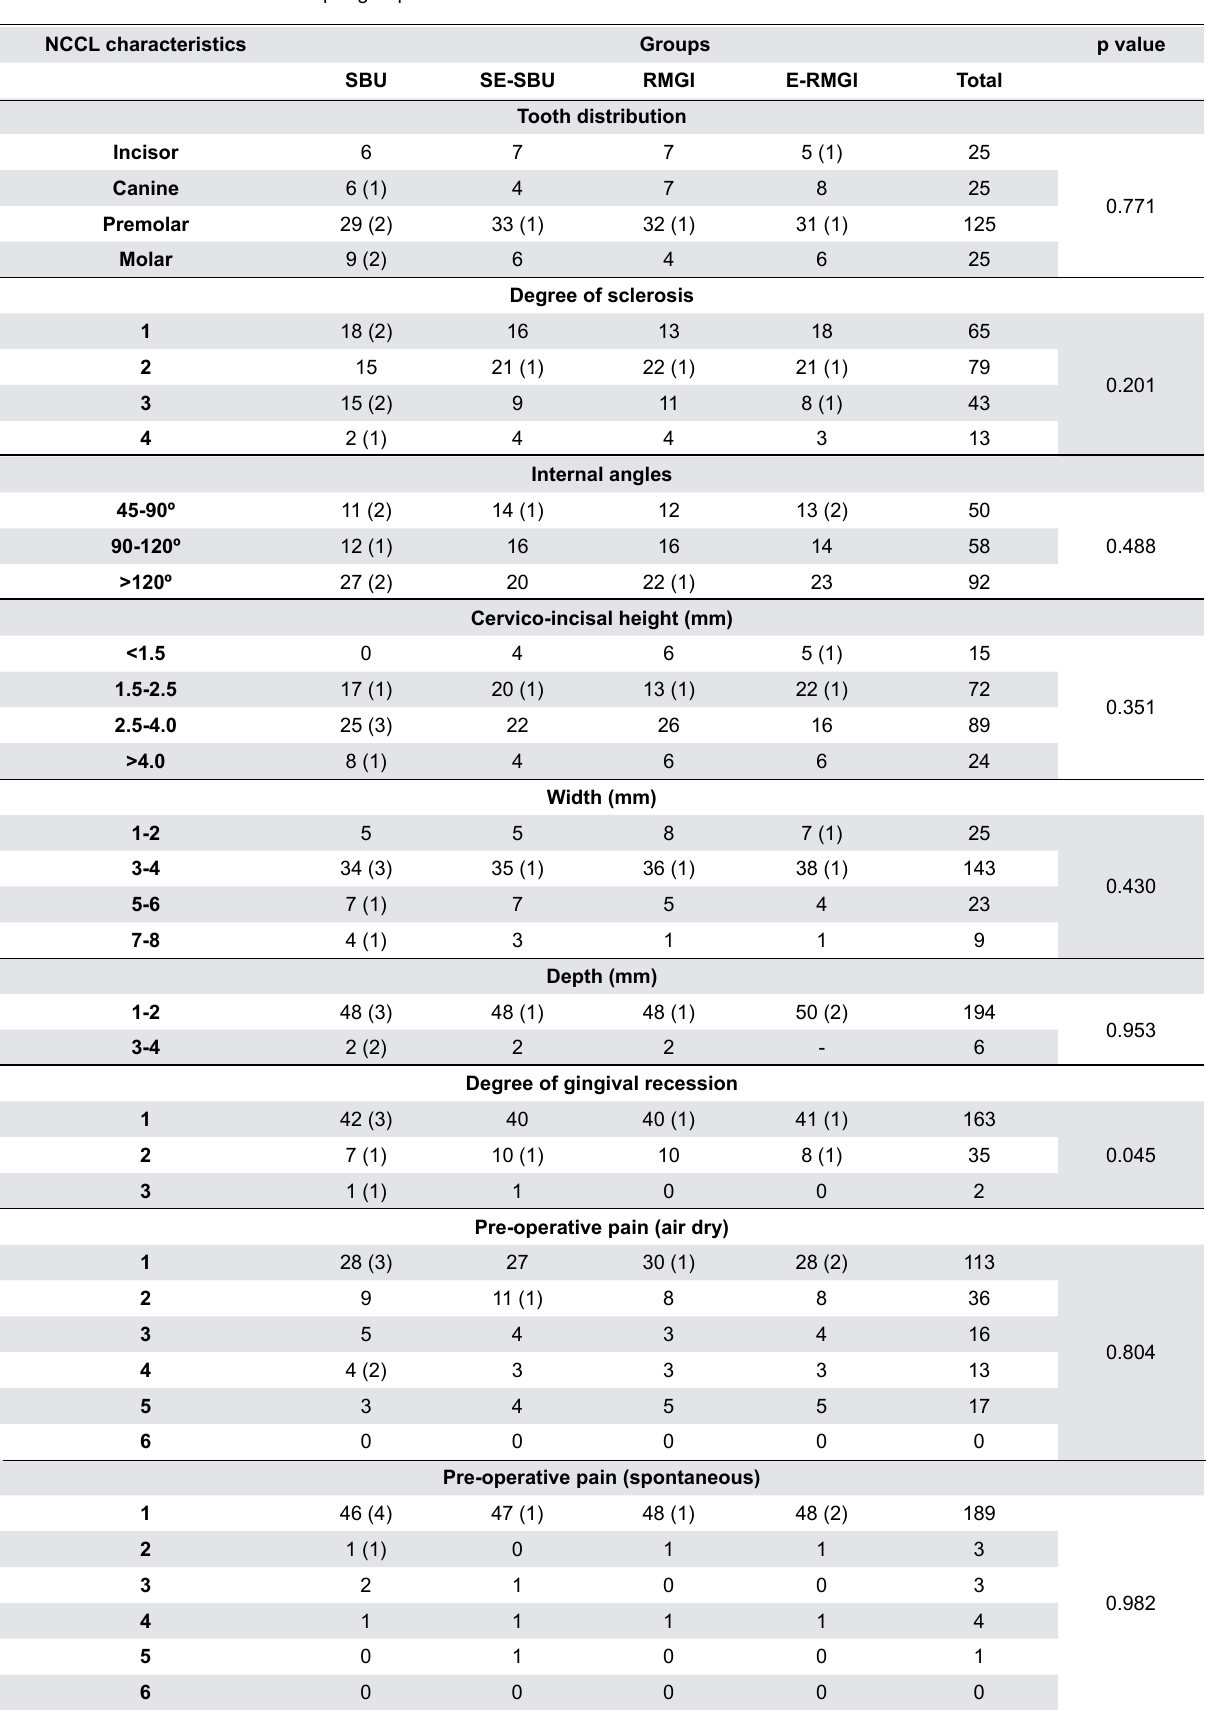
Table 2- NCCL initial characteristics per